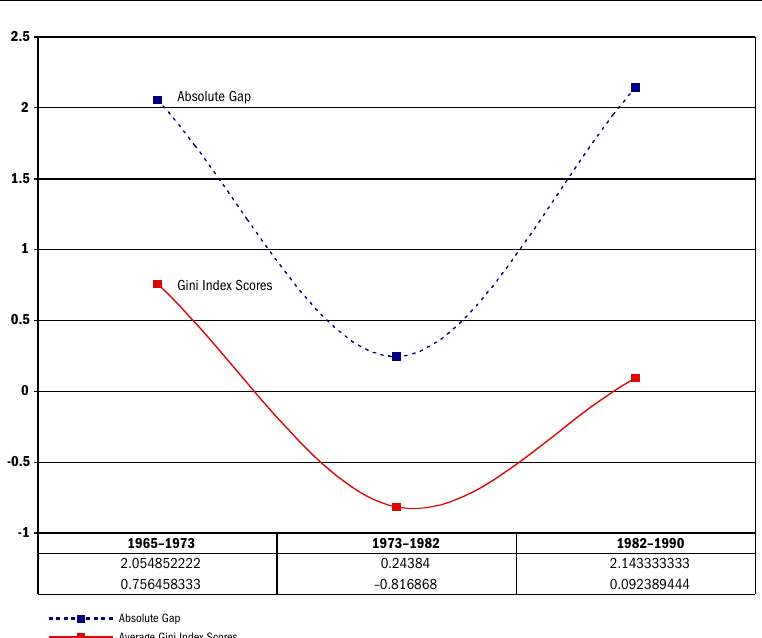
Figure 3 – Rate of Change for Global and National Inequalities, 1965-1990